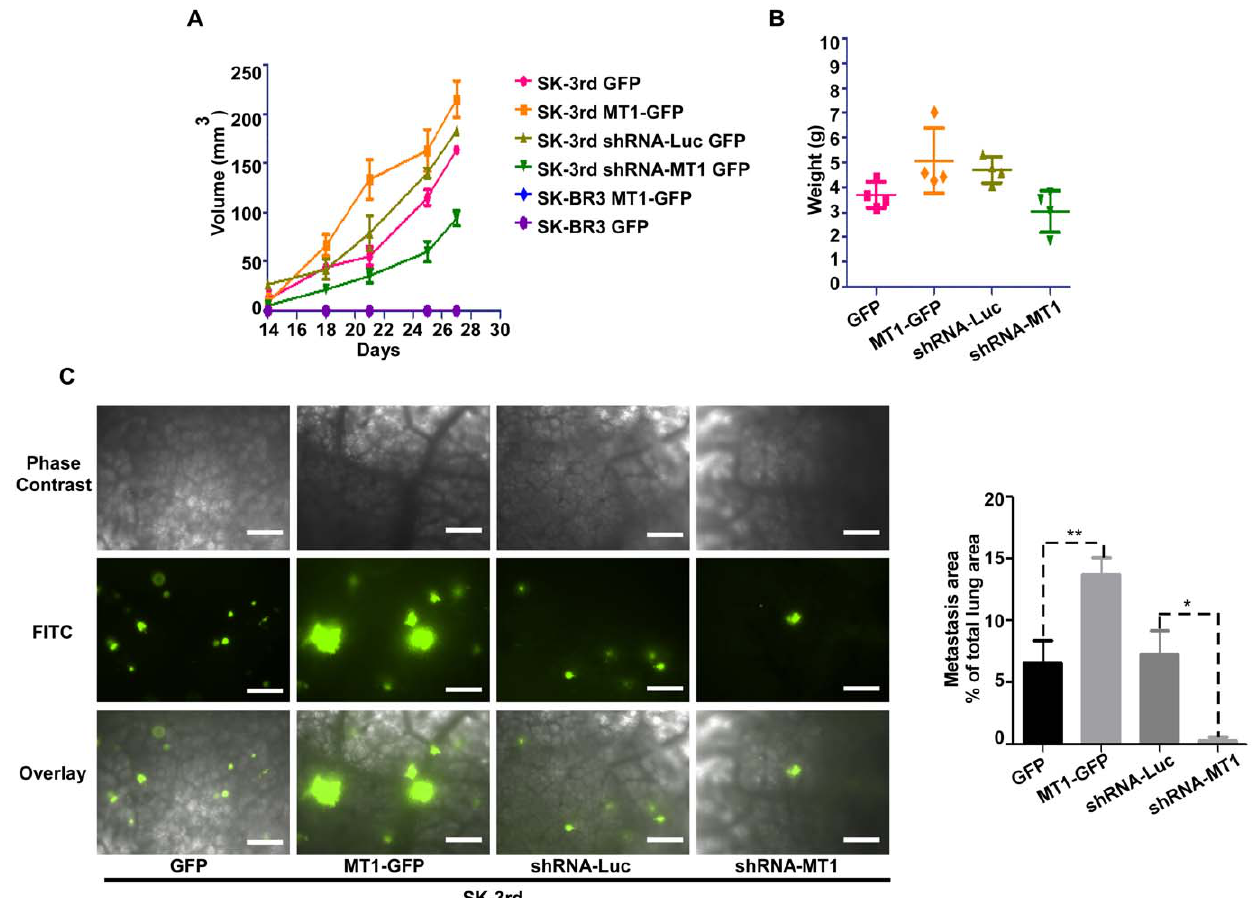
Figure 4. MT1-MMP is required for metastasis of SK-3rd TICs. SK-3rd TICs expressing exogenous genes for either upregulation or downregulation of MT1-MMP as indicated were injected into immunodeficient mice and tumor growth was monitored (A). After four weeks, the experiments were terminated and entire tumor was harvested and weighed (B). The lungs were examined under phase contrast (C, Lift upper panel) and fluorescent (Right lower panel) microscopy. Metastasized tumors were identified based on GFP auto-fluorescence and measured using Nikon NIS Elements. Quantification of total lung metastasis burden in mice bearing tumor cells as indicated was determined based on percentage of metastasized tumors (area) over lungs (area) under the same field (C, Right panel). Bar, 100 m